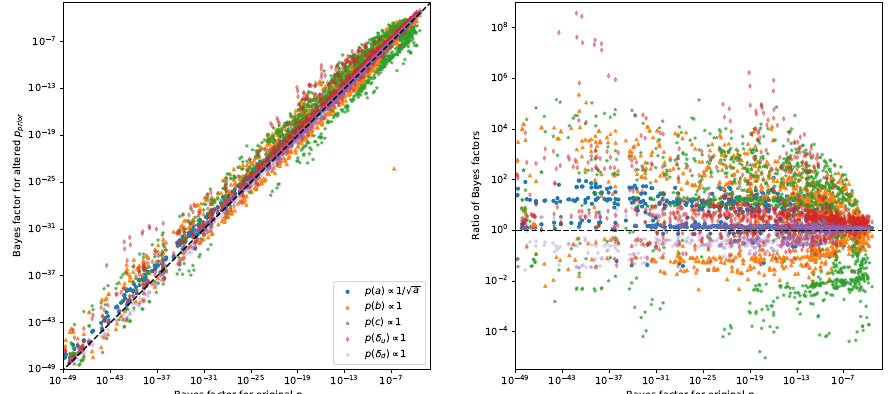
Figure A1. Comparison of Bayes factor using standard prior with Bayes factors using altered priors. Each dot is a combination of habitability criteria. The left plot compares the two Bayes factors directly and indicates a strong correlation with some scatter. The right plot divides the new Bayes factor by the original to better indicate the residual